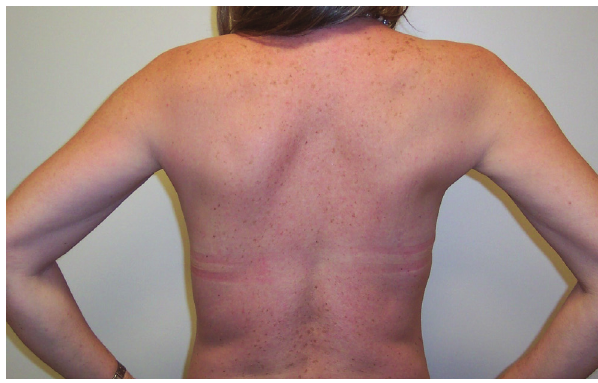
Figure 1 - A latissimus dorsi flap deformity of the right side. Although subtle, this difference can be very uncomfortable when wearing certain clothes.